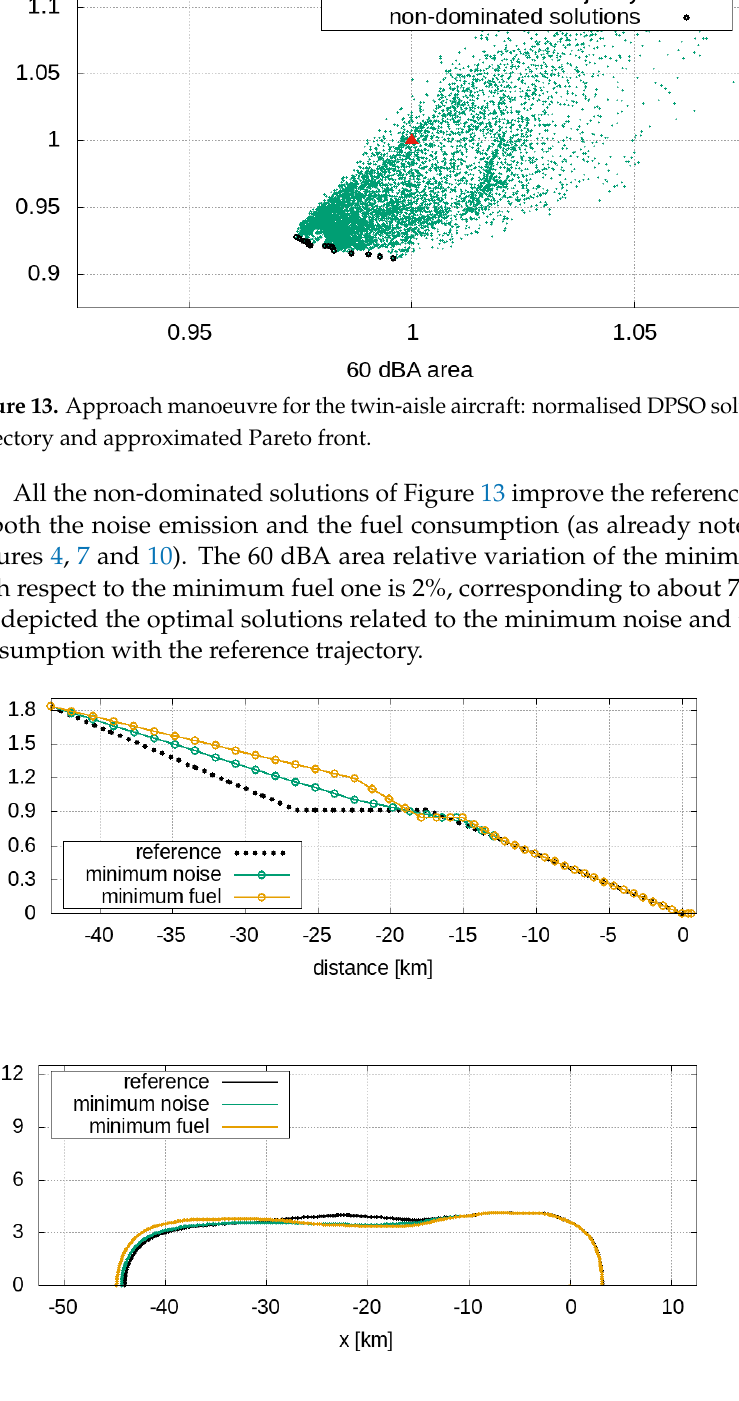
Figure 14. Approach manoeuvre for the twin-aisle aircraft: flight paths and 60 dBA contours for the reference trajectory and the optimal solutions related to the minimum noise and the minimum fuel consumption: ( a ) flight path, ( b ) 60 dBA